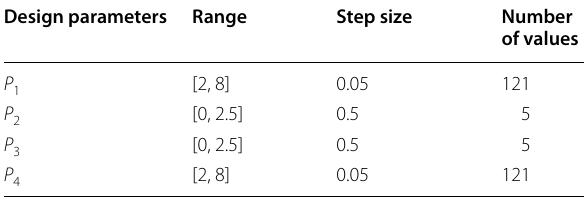
Table 3 Palm design parameters Design